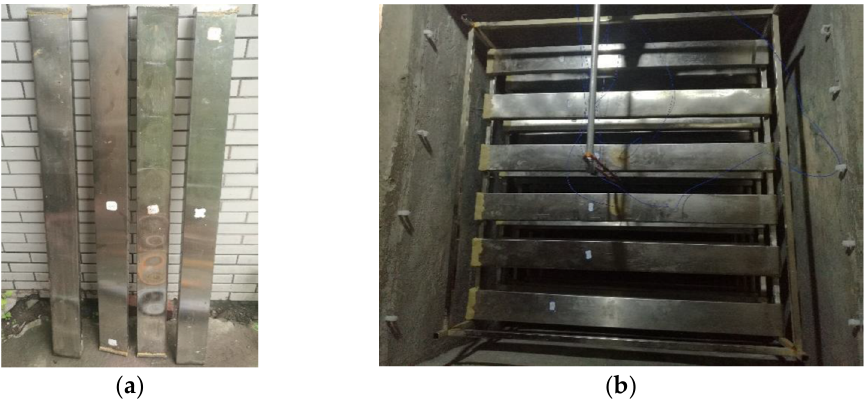
Figure 2. Physical test bench. ( a ) The appearance of the reservoir; and ( b ) The arrangement of the phase change module. Table 1. Setting the height of each layer of the bracket.